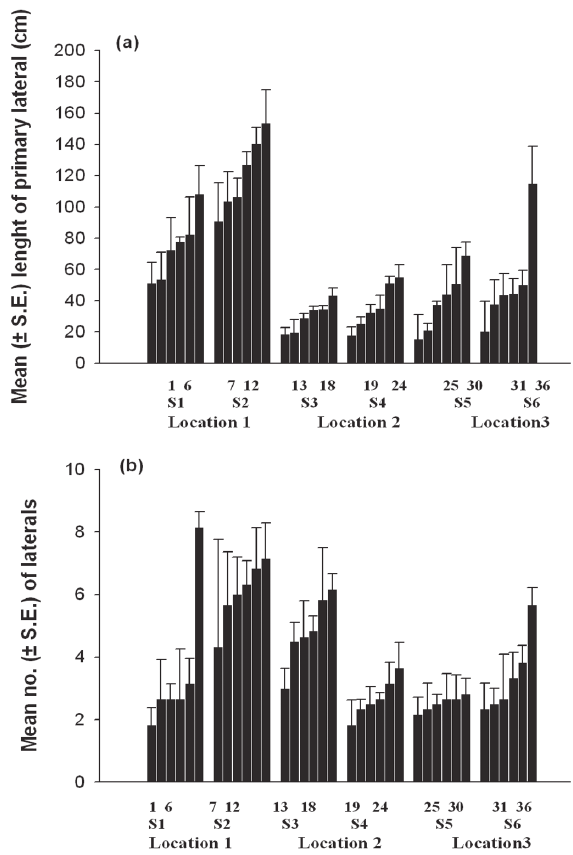
Fig . 3. – variation of morphological variables at quadrat scale (n= 6). Mean (± s.e.) of (a) length of primary lateral (cm) and (b) number of laterals in each of the 6 quadrats (Q) within the 2 sites (s1-s6) in the 3 locations at ría de vigo (ria 1). Only March is represented.